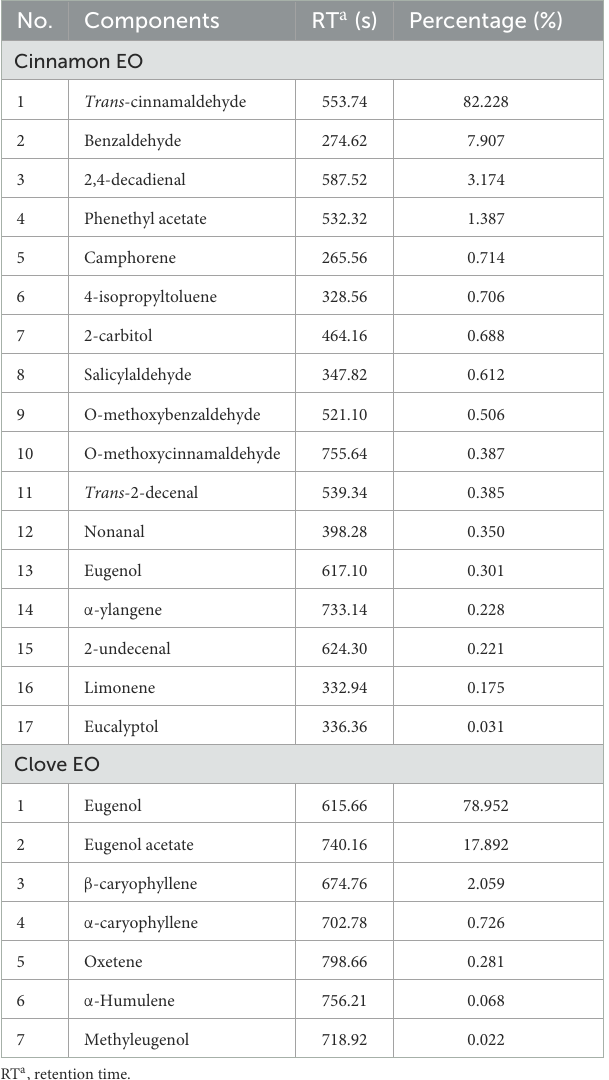
TABLE 1 Chemical compositions of cinnamon and clove